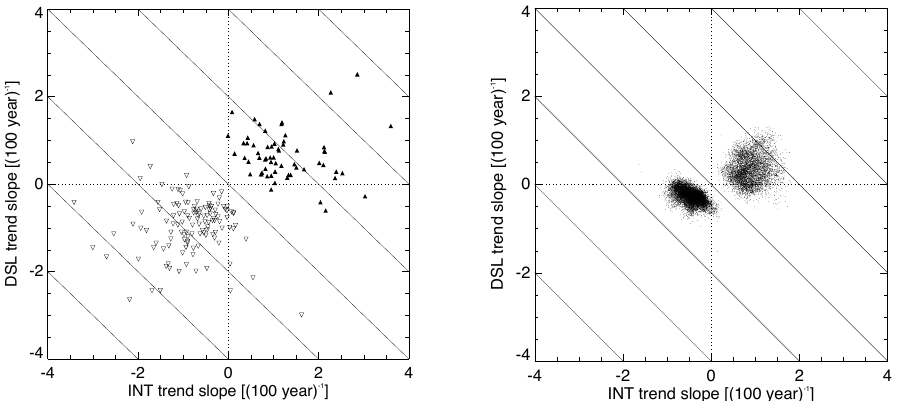
Figure 11. Dispersion diagram of the DSL trend slope vs. INT trend slope for all stations in the base dataset ( left ) and all pixels in the CHIRPS dataset ( right ) with significant HY-INT trend slope. Notice that because of Equation (10), the trend slope of HY-INT is the sum of the trend slopes of INT and DSL. This equation explains the slanted iso-lines for the HY-INT trend